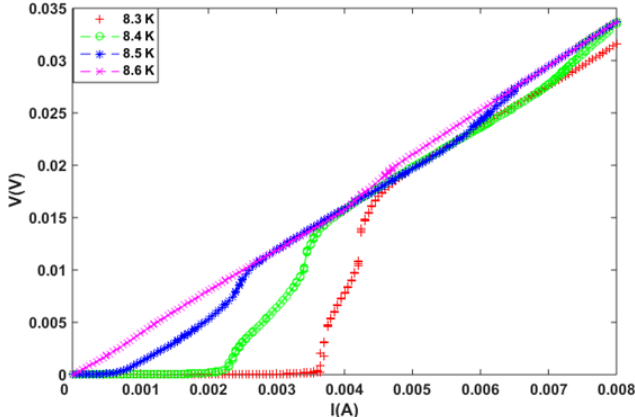
Figure 1. Scanning electron micrograph (SEM) of a superconducting Nb film with a diluted square array of holes.